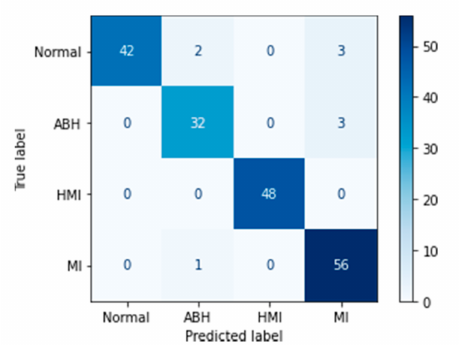
Figure 6. Confusion matrix for the MobileNet V2 model.